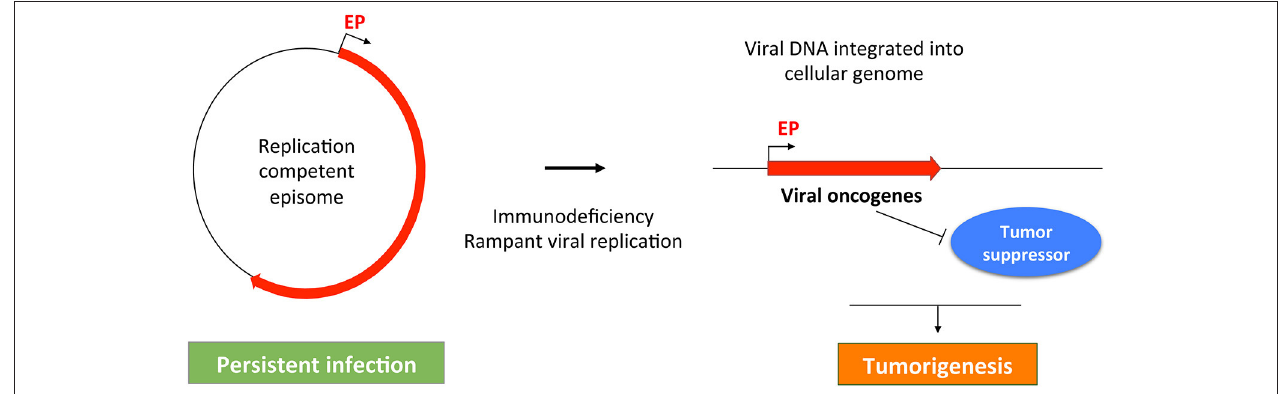
FIGURE 3 | A common theme in MCPyV- and HPV-induced tumorigenesis. MCPyV and HPV both replicate as episomes in persistently infected cell. Failure of host immune system may cause uncontrolled viral replication, which can stimulate viral DNA integration into the host cellular genome. The integrated viral genome expresses viral oncogenes that can inhibit tumor suppressors to induce malignant transformation. Red line indicates the early region of the oncogenic viruses. EP, Early